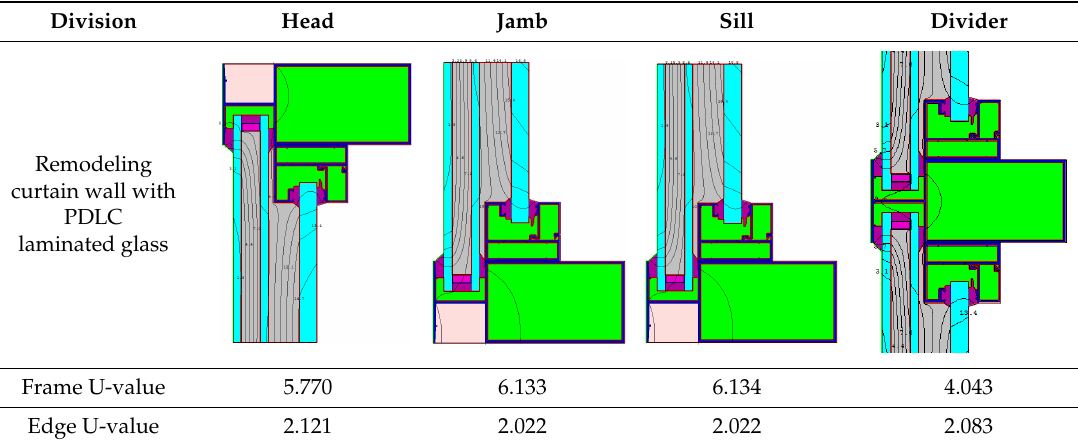
Table 9. Analysis results for the thermal properties of the curtain wall frame with PDLC window. Division